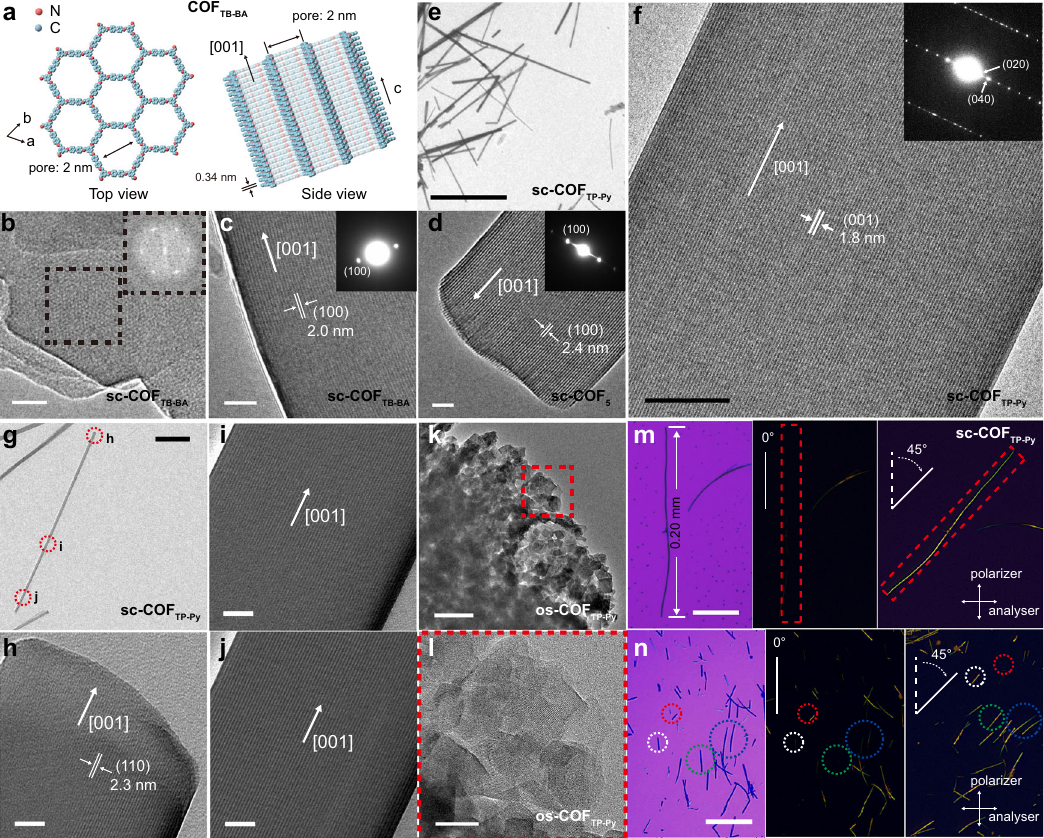
Fig. 2 Characterization of the crystalline structure. a Top and side view of COF TB-BA . b Cross-section TEM image of sc-COF TB-BA . The inset is the FFT pattern obtained from the dashed square. c – g TEM images of sc-COF TB-BA ( c ), sc-COF 5 ( d ), and sc-COF TP-Py ( e – g ). The insets show the corresponding SAED patterns. h – j High-resolution TEM images of a sc-COF TP-Py crystal taken from the regions marked by red circles in ( g) . k , l TEM and enlarged TEM images of os-COF TP-Py . m , n OM and cross-polarized OM images of a 0.20 mm long sc-COF TP-Py crystal ( m ) and sc-COF TP-Py crystals ( n ). The scale bars are 20 nm in ( b – d ), ( h – j ), 50 nm in ( f , l ), 200 nm in ( k ), 2 μ m in ( g ), 10 μ m in ( e ), 50 μ m in ( m ) and ( n ).